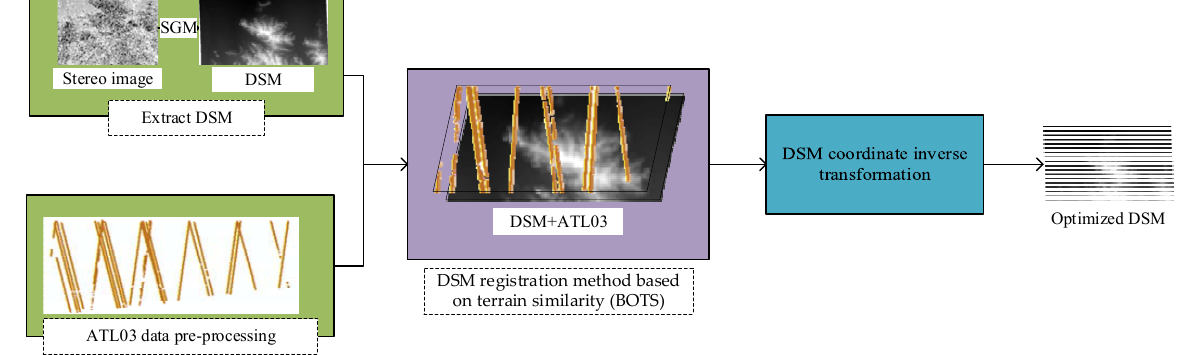
Figure 2. DSM geometric accuracy optimization process based on terrain similarity.